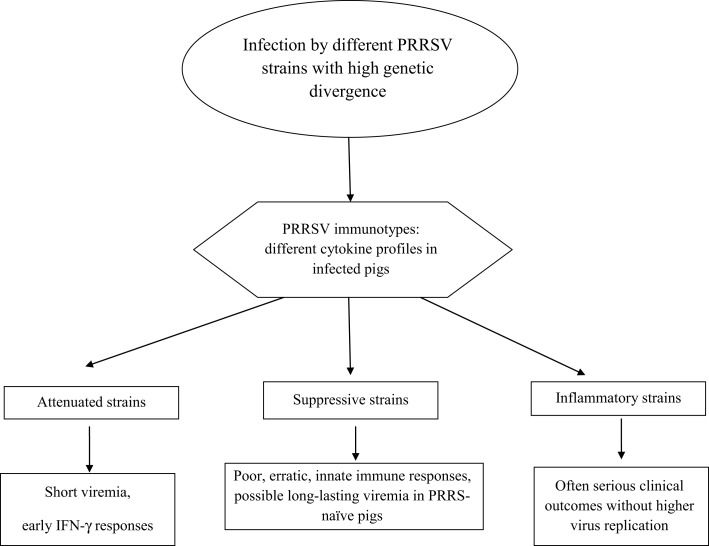
PRRSV phenotypes.